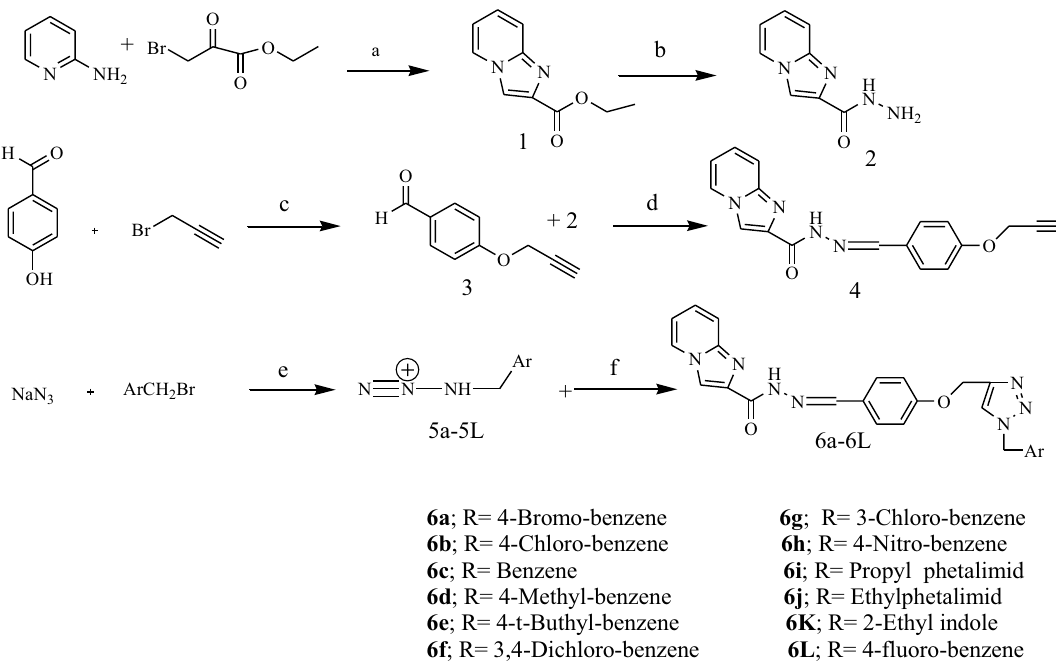
Figure 3. Synthesis procedure: Reagents and conditions were as follows: ( a ) EtOH, 24 h, Reflux. ( b ) NH 2 NH 2 .